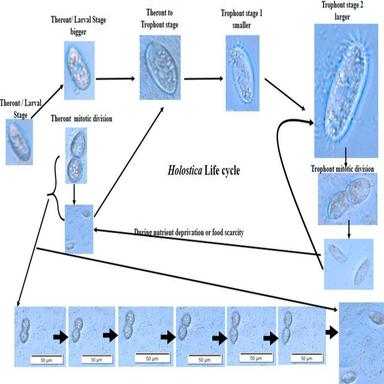
Possible life cycle of Holosticha: The sexual and asexual reproduction was observed.Conjugation of two ciliate cells of a compatible mating type was with sexual reproduction. Asexual reproduction by transverse division with the anterior half of the ciliate forming new organism and other posterior half forming another new cell (Trohont stage in division) as complete adult stage (Trophont). No tomont or resting stages was found. The theront stages directly developed into trophont or adult stages during favou